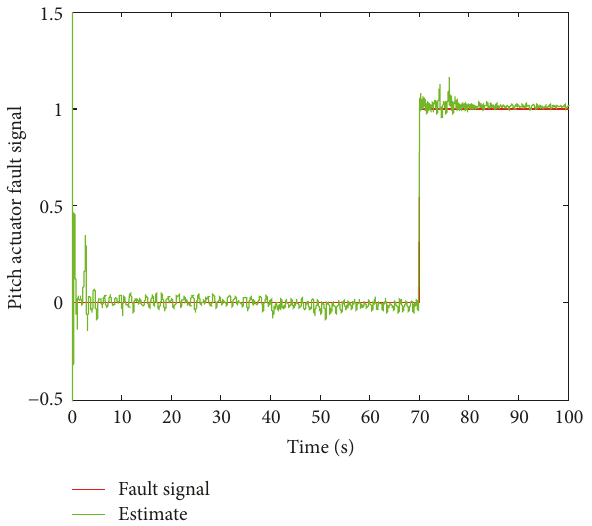
Figure 3: Pitch actuator original fault 𝜃 𝑓 and its estimate with 𝑓 𝑠 = − 0.2.